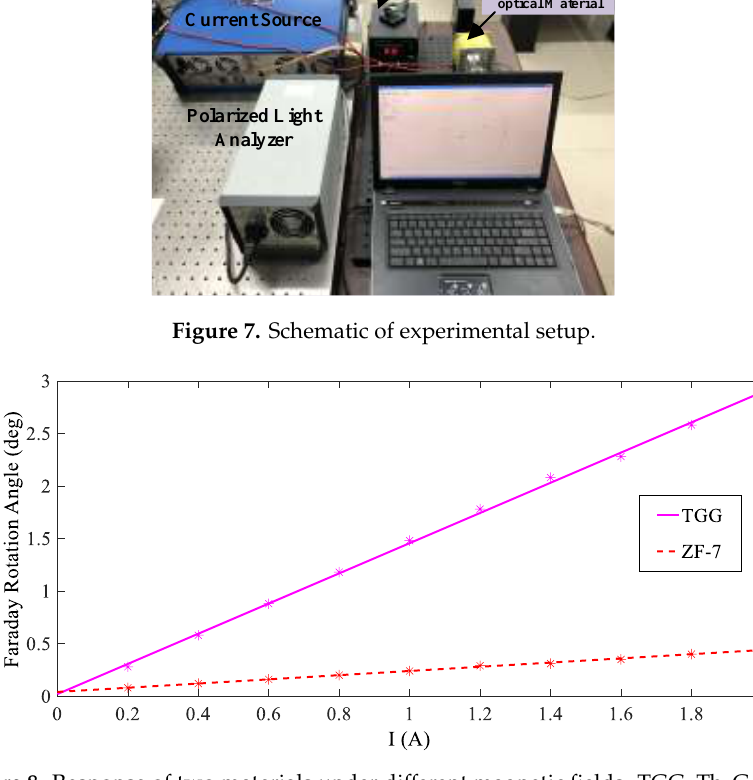
Figure 8. Response of two materials under different magnetic fields. TGG, Tb 3 Ga 5 O 12 .